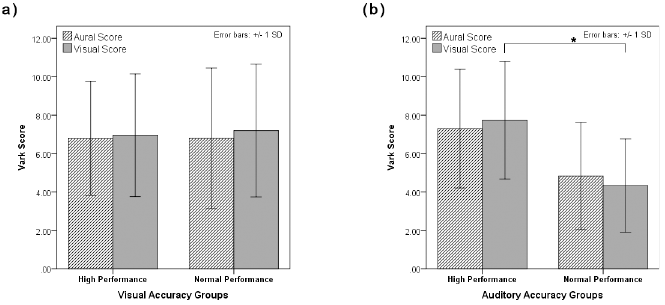
Fig 6. Differences between high performance and normal performance groups in visual and aural VARK scores. (a) during performance of visual task and (b) during performance of auditory